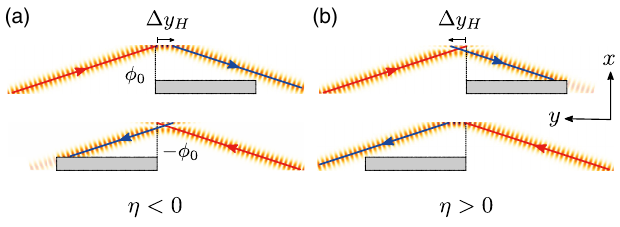
FIG. 4. Nonreciprocal plasmon filter. (a), (b) Plasmon Hall shift = ω displacement at a fixed η ¼ ω are identical for beams with c q incident angle ϕ 0 and − ϕ 0 . Gray regions are areas inside which plasmons damp quickly; see text. For plasmon beams incident from the left-hand (right-hand) side, the reflected beam can bypass the damping region when η is negative (positive); these reflected beams can be collected at an all-electrical plasmon detector stationed close by ( p - n junction thermoelectric detector [35]). In contrast, plasmon beams incident from the right-hand (left-hand) side pass through the damping region and are damped when η is negative (positive). Red (incident) and blue (reflected) lines are beam trajectories obtained from Eq. (14). Parameters used are as follows: the width of the wave is π =q , the same = ω as Fig. 3(d), ϕ 0 ¼ 2 π = 5 , and ω cot ϕ 0 is taken to c q ¼ (cid:3) maximize the plasmon Hall